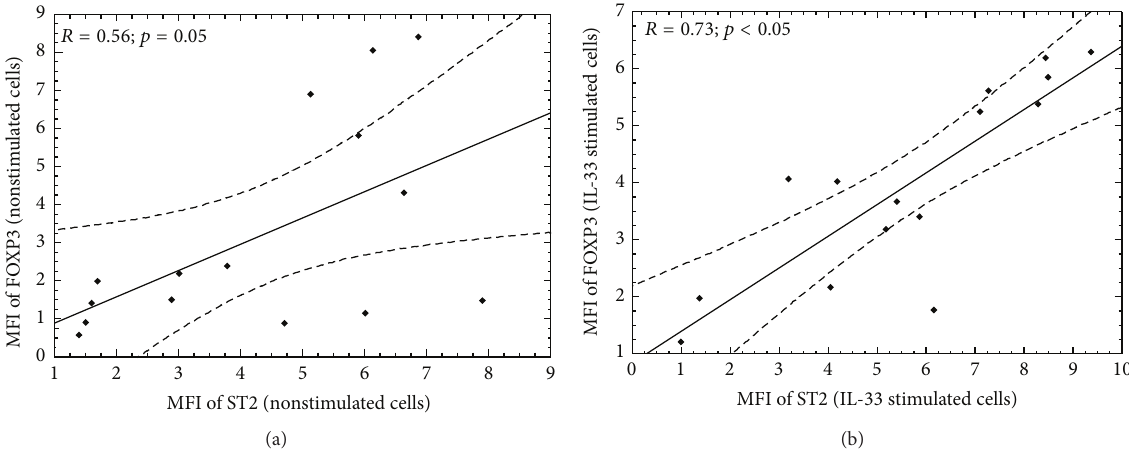
Figure 4: Association between the expression of FOXP3 and that of ST2 among CD 4 + CD 25 high FOXP 3 + cells after IL-33 in vitro treatment in DM1patients.ExpressionvaluesofFOXP3andST2definedasMFIamongnonstimulated(a)andIL-33stimulated(b)CD 4 + CD 25 high FOXP 3 + cells in a group of patients with type 1 diabetes were correlated. The Spearman test was used to calculate the strength of correlation. MFI: Mean Fluorescence